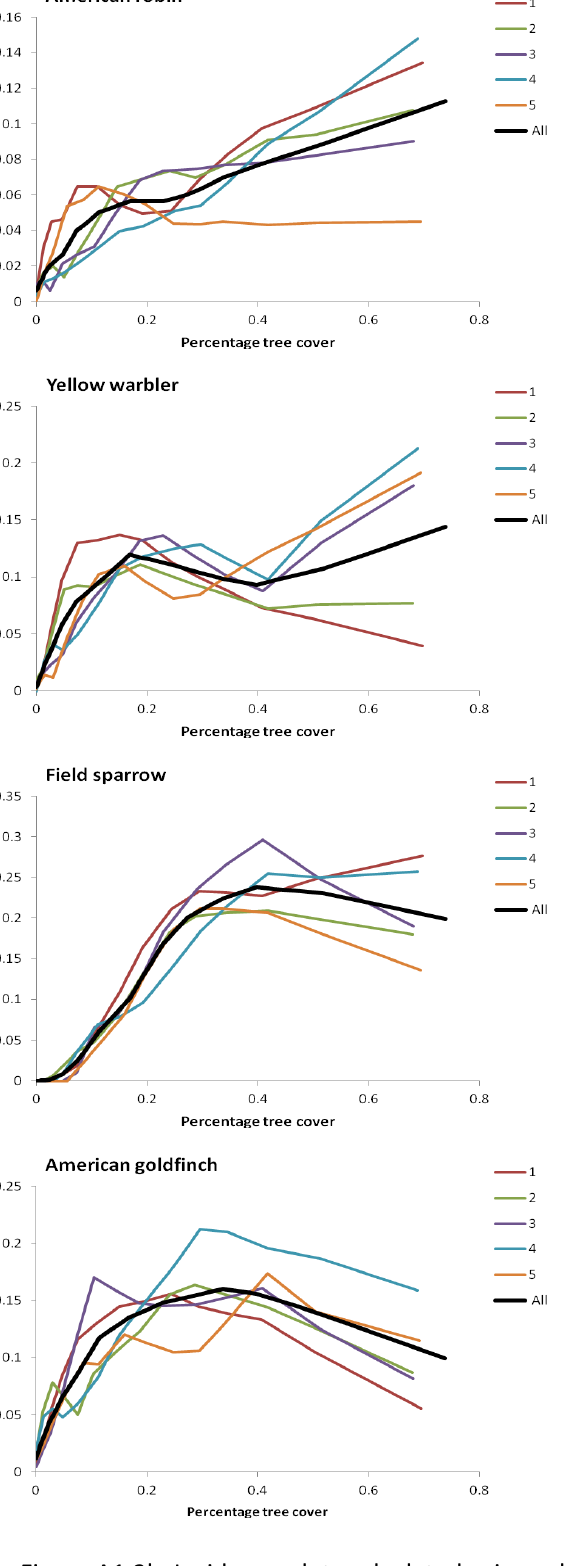
Figure A1.3b Incidence plots calculated using subsamples of the data and all data for 8 of 16